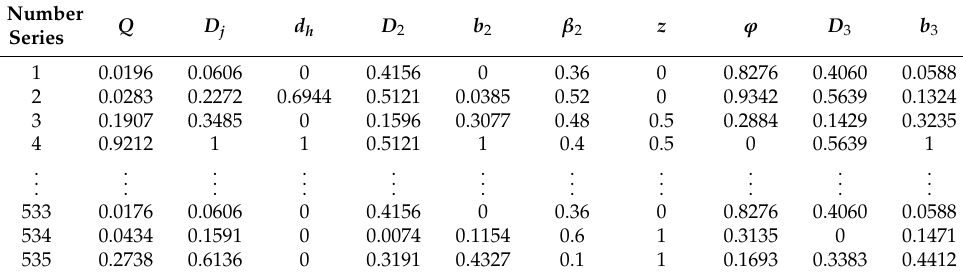
Table 1. Partially normalized dimensionless geometric